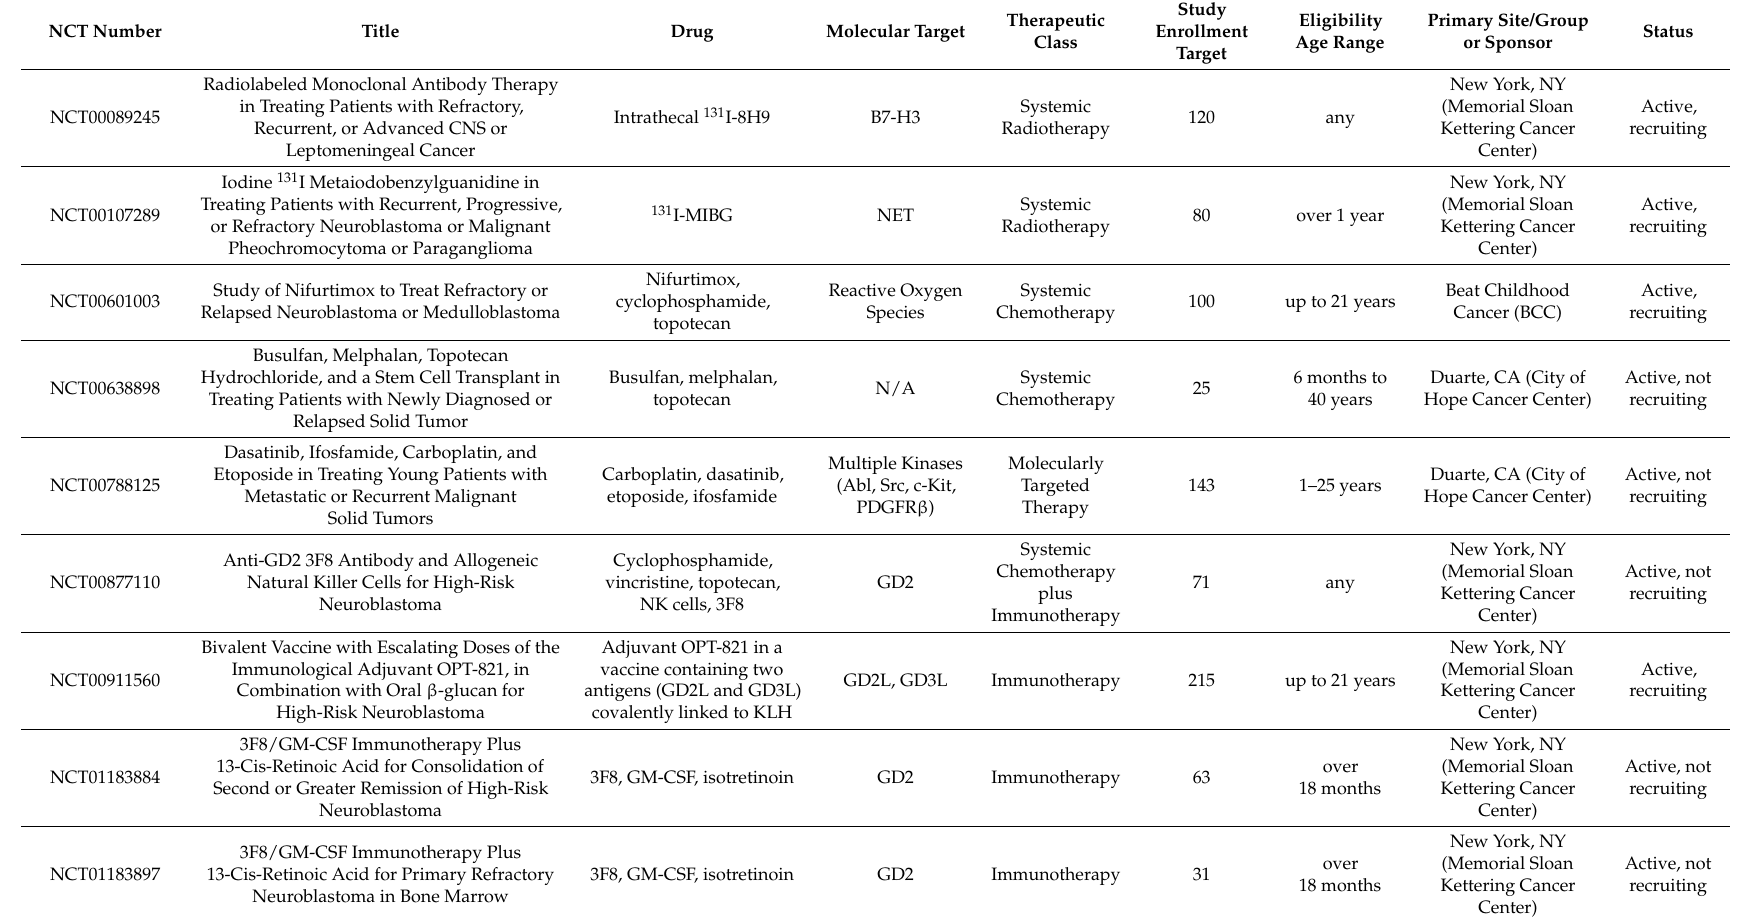
Table 1. Current open clinical trials for refractory and relapsed